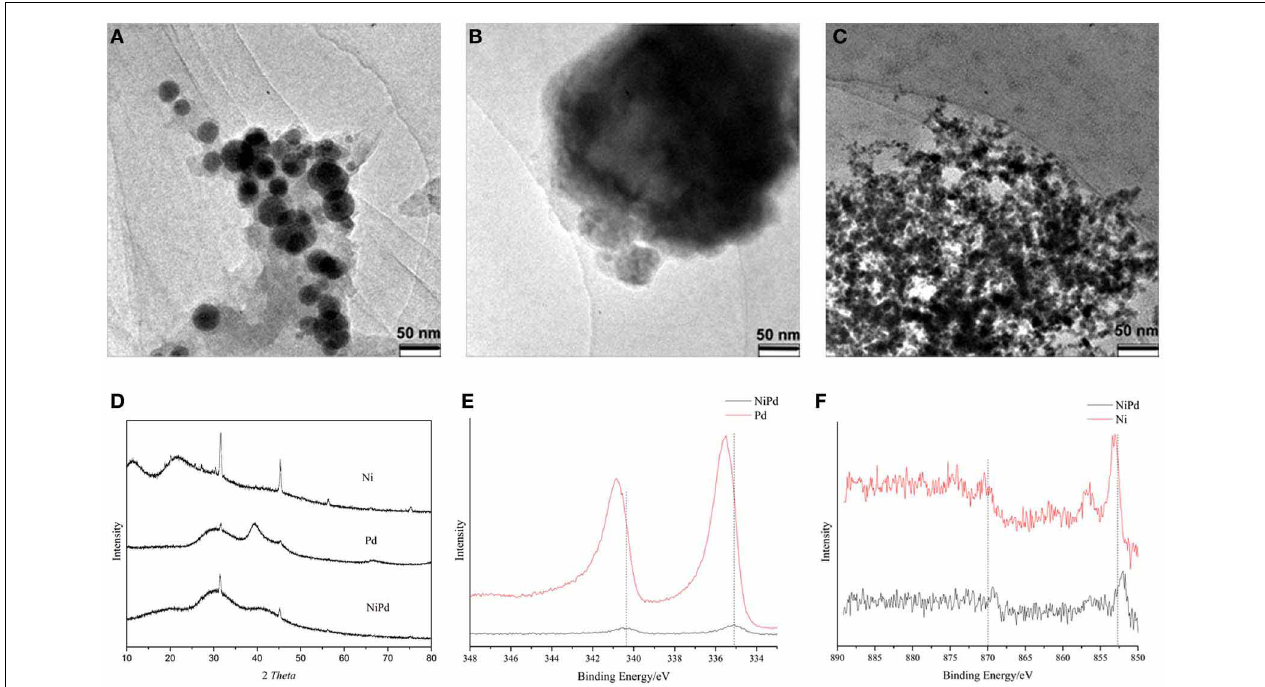
FIGURE 3 | TEM images of (A) Ni, (B) Pd, and (C) Ni 7 Pd 3 catalysts. (D) XRD patterns of Ni, Pd, and Ni 7 Pd 3 . (E) Pd 3d and (F) Ni 2p XPS spectra for Ni 7 Pd 3 , Ni, and